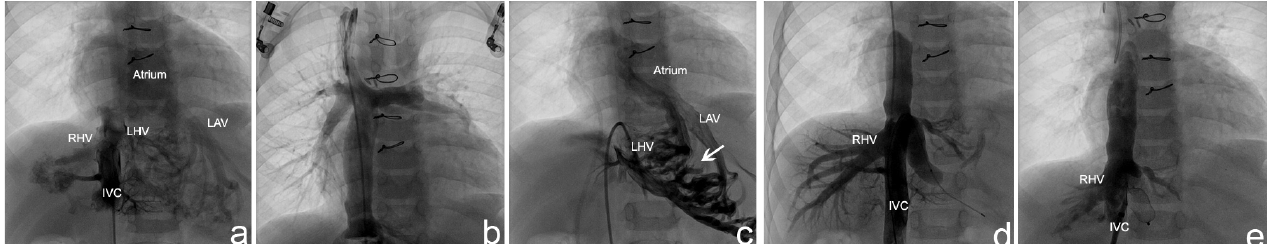
Fig. 1 - A: Angiogram of the inferior vena cava: a veno-venous malformation between the inferior vena cava and the atrium is detected with a distal collector. B: Angiogram of the superior vena cava revealing poor filling of the pulmonary arteries and rapid retrograde filling of the left inferior caval vein. C: Left hepatic vein originating from the inferior vena cava, dividing into multiple sinusoidal channels in the liver, joining with the left accessory veins, and draining into the pulmonary venous atrium. D: Occlusion test with a balloon in the distal collector under the common atrium. E: Atrial septal device that performed a nearly complete occlusion of the veno-venous malformation. RHV=right hepatic vein; LHV=left hepatic vein; IVC=inferior vena cava; LAV=left accessory veins. Arrow shows multiple sinusoidal channels.